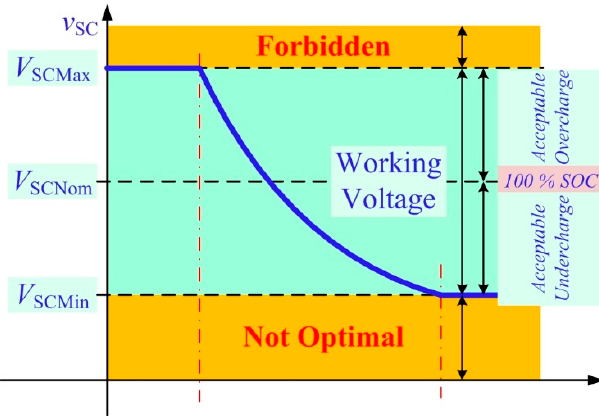
Figure 5. Definition of the SC voltages: V SCMax , V SCMin , V SCNom .